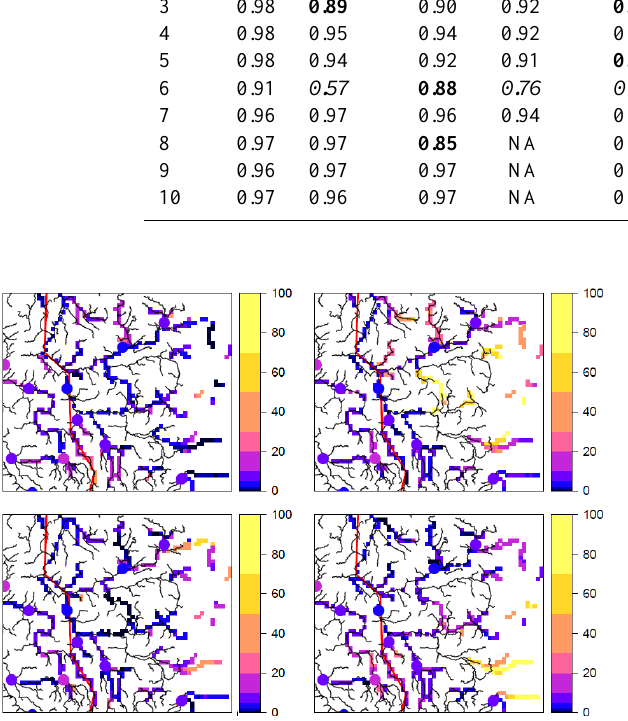
Figure 3. Predicted (dots) and simulated specific runoff (pixels) for 10 days lead time for a region on both sides of the German/Polish border (red